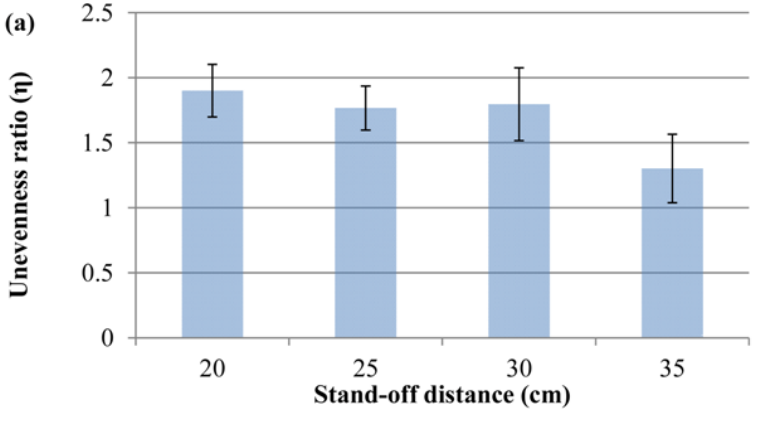
Figure 6. The effect of stand-off distance on the unevenness ratio of EMAA single splats ( a ) Glass and ( b ) Mild steel